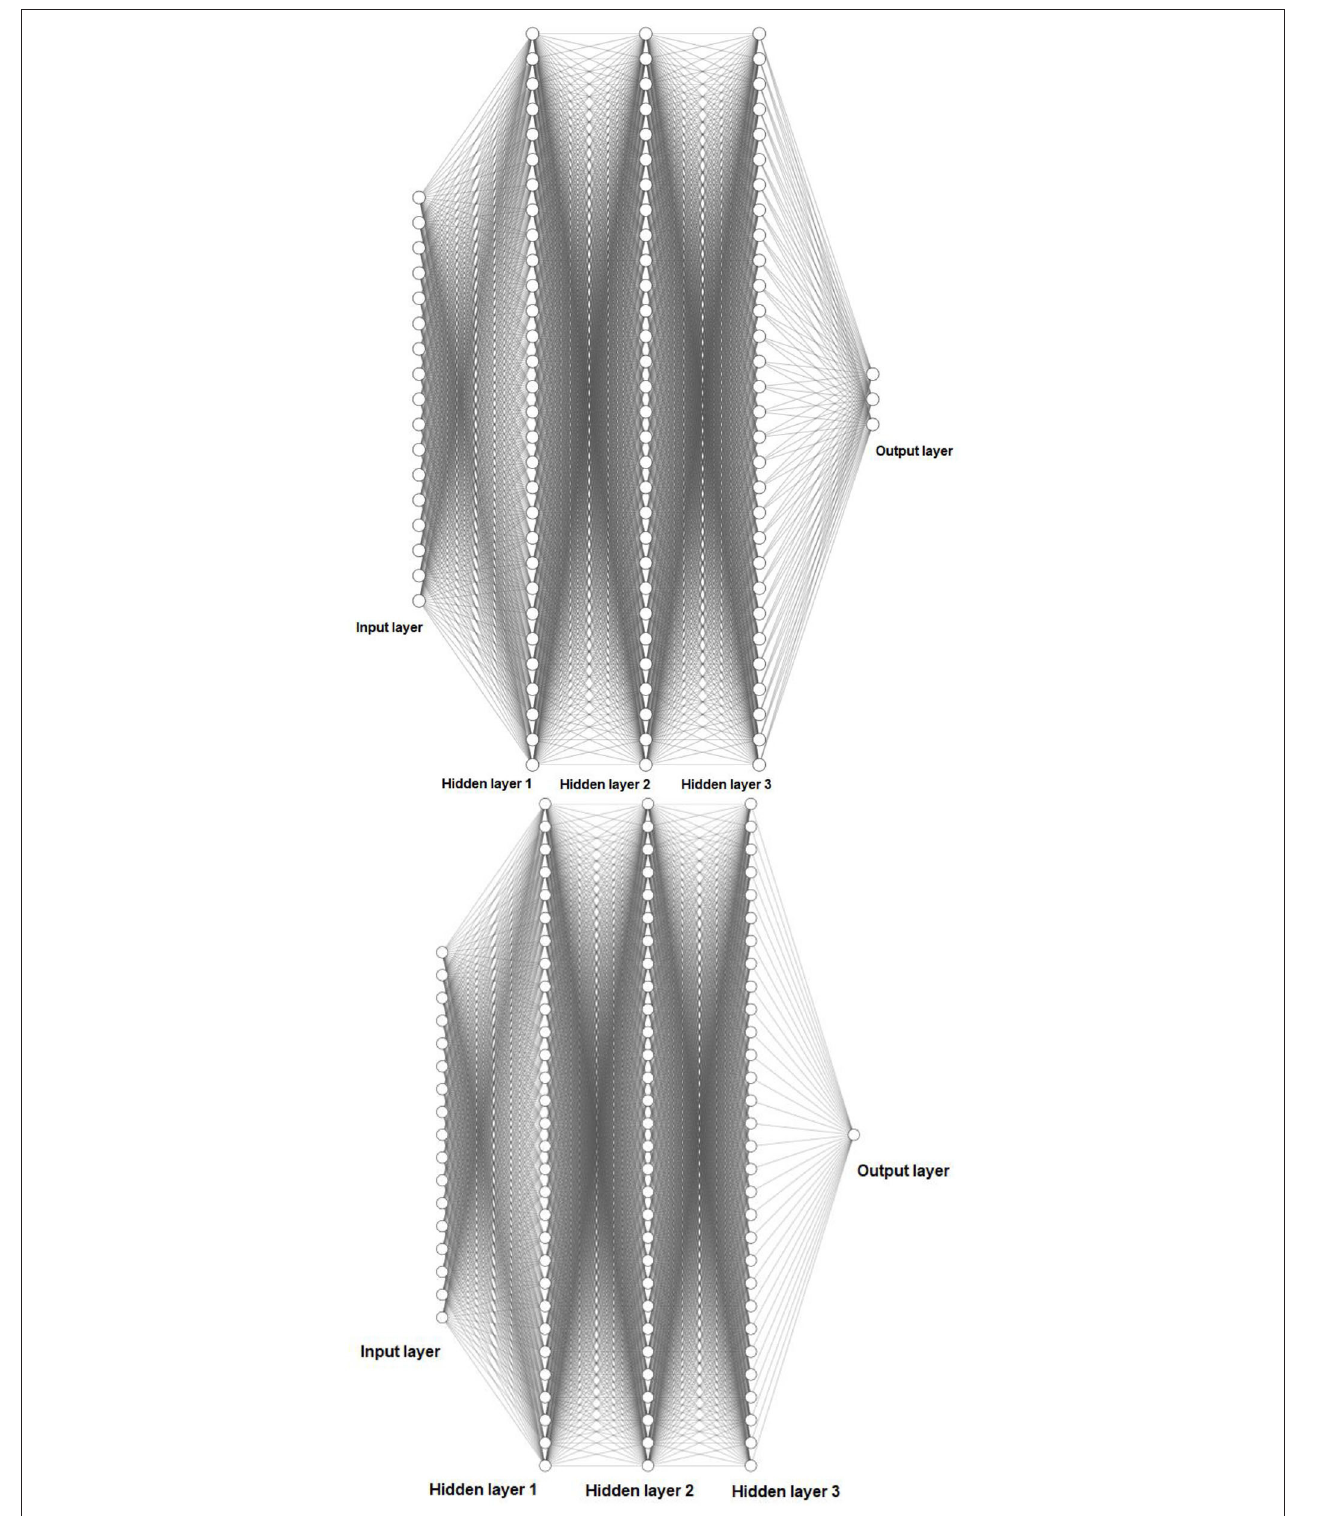
FIGURE 3 | Schematic representation of (above) a deep five-layer (17 × 30 × 30 × 30 × 3) ANN as used in Network 1, and (below) a deep five-layer (17 × 30 × 30 × 30 × 1) ANN as used in Networks 2, 3, and 4.